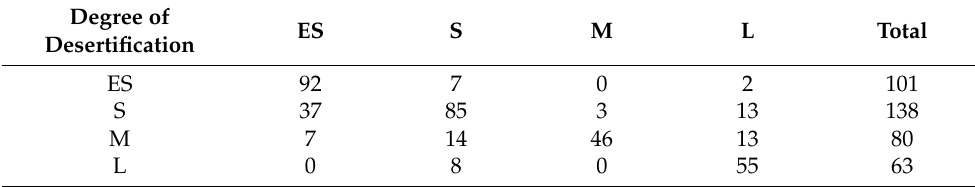
Table 4. Confusion matrix for accuracy verification by the data set. Degree